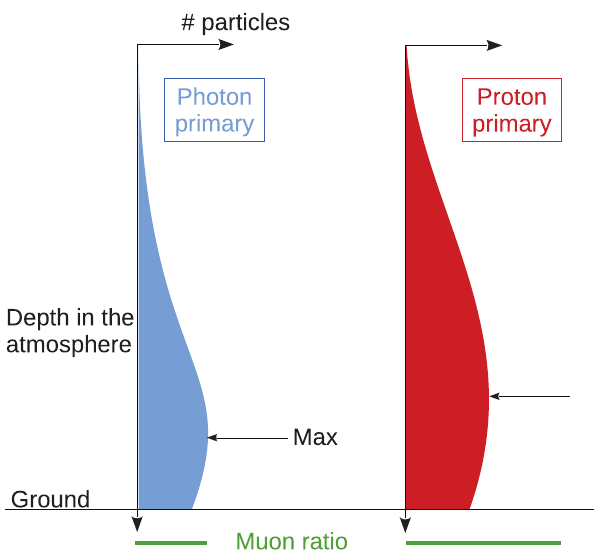
Figure 3. Scheme of the differences between photon-/proton- induced showers. EAS induced by a photon primary have a maximum development depth closer to the ground and less muons on ground compared to a proton-induced one. All quantities in this fi gure are simply to highlight the tendencies and should not be taken as measurements of any kind.